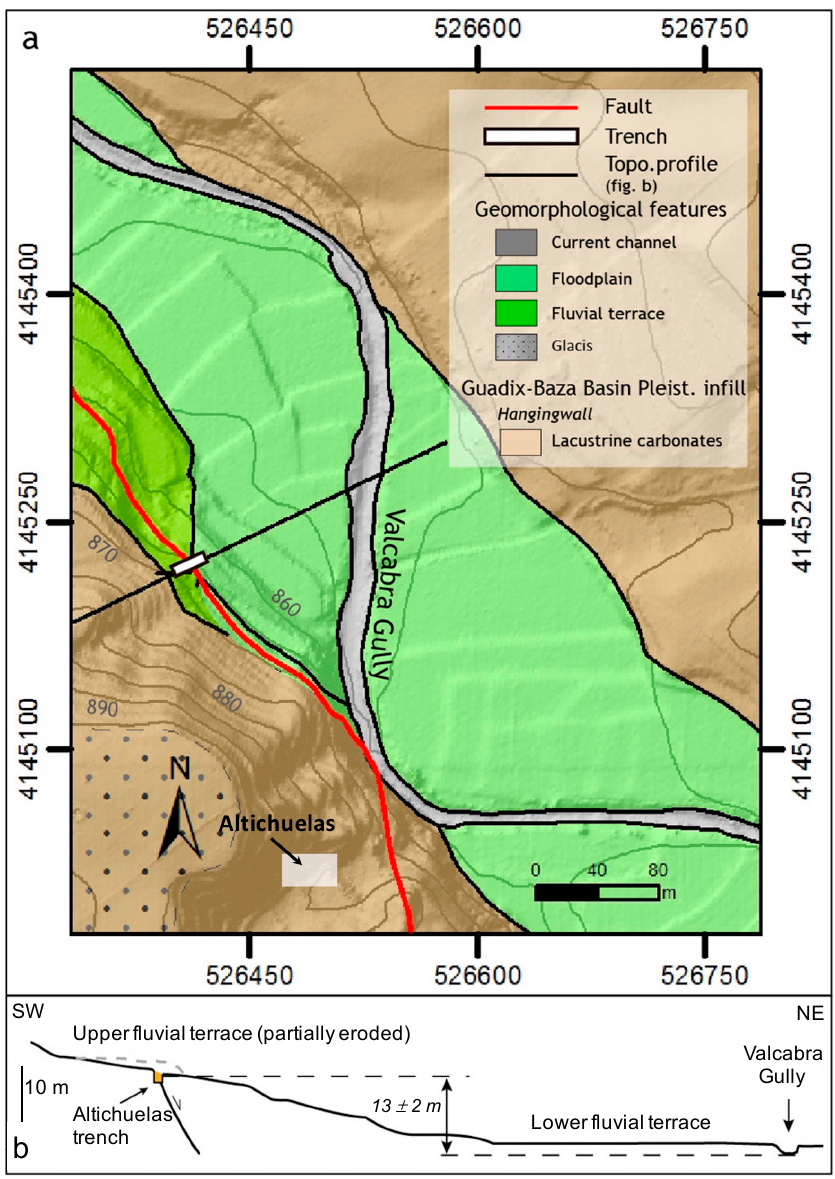
Figure 9. ( a ) Geological–geomorphological map of the central sector of the Baza Fault. Location in Figure 1. ( b ) Geological cross section along the southern sector. Modified from Castro and collaborators [63].